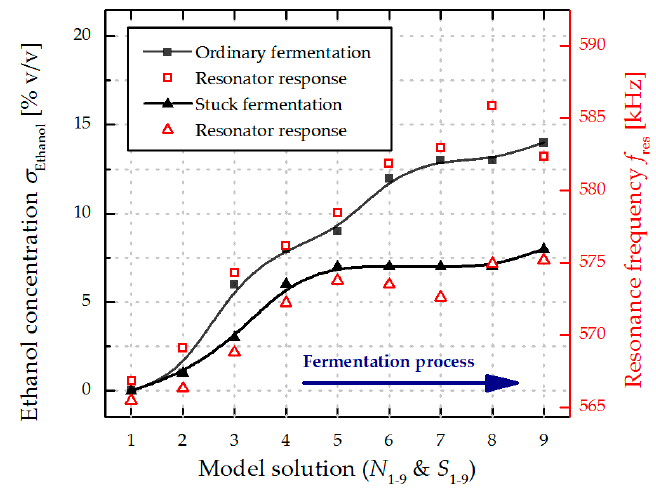
Figure 8. Fifteen-mode frequency response analysis of an ordinary ( N 1–9 ) and a stuck ( S 1–9 ) fermentation process in comparison to the nominal ethanol concentration of the investigated model solutions. The inserted lines serve as guide to the eye.